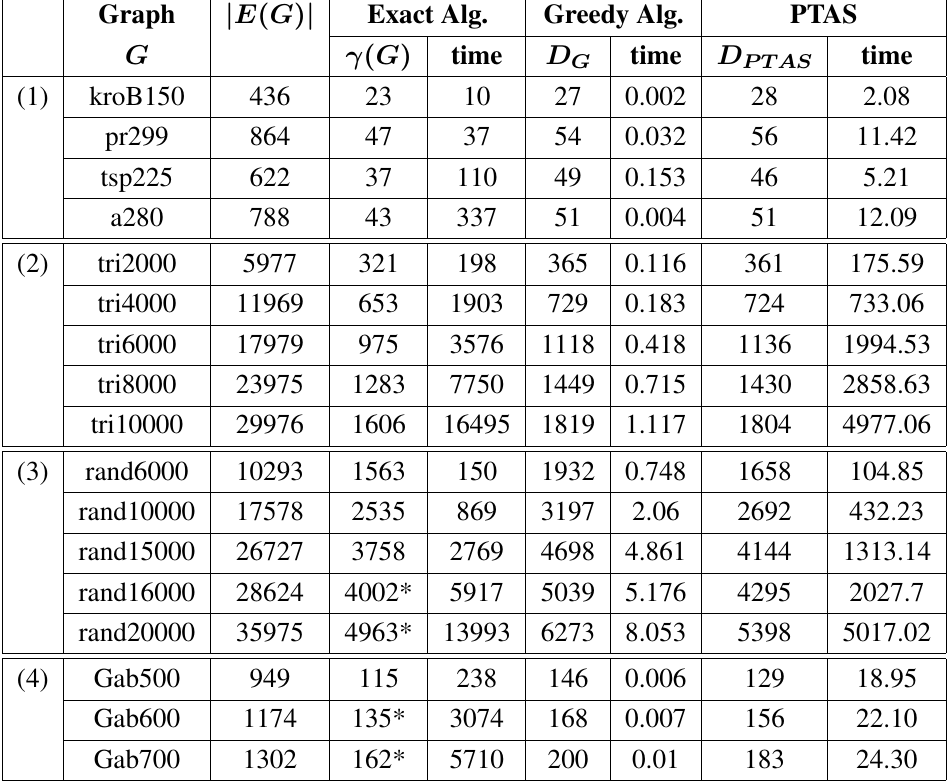
Table 3. Computational results for Exact, Greedy and PTAS algorithms for small instances (time in